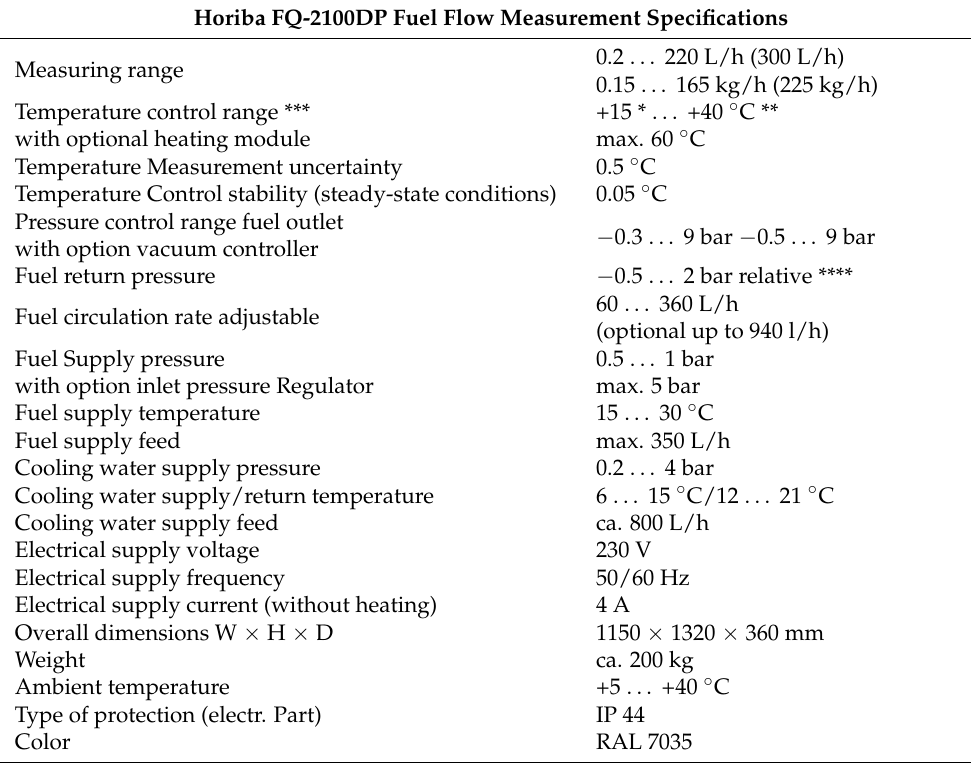
Table A2. Horiba Fuel Flow Measurement Specifications (Source: Horiba).